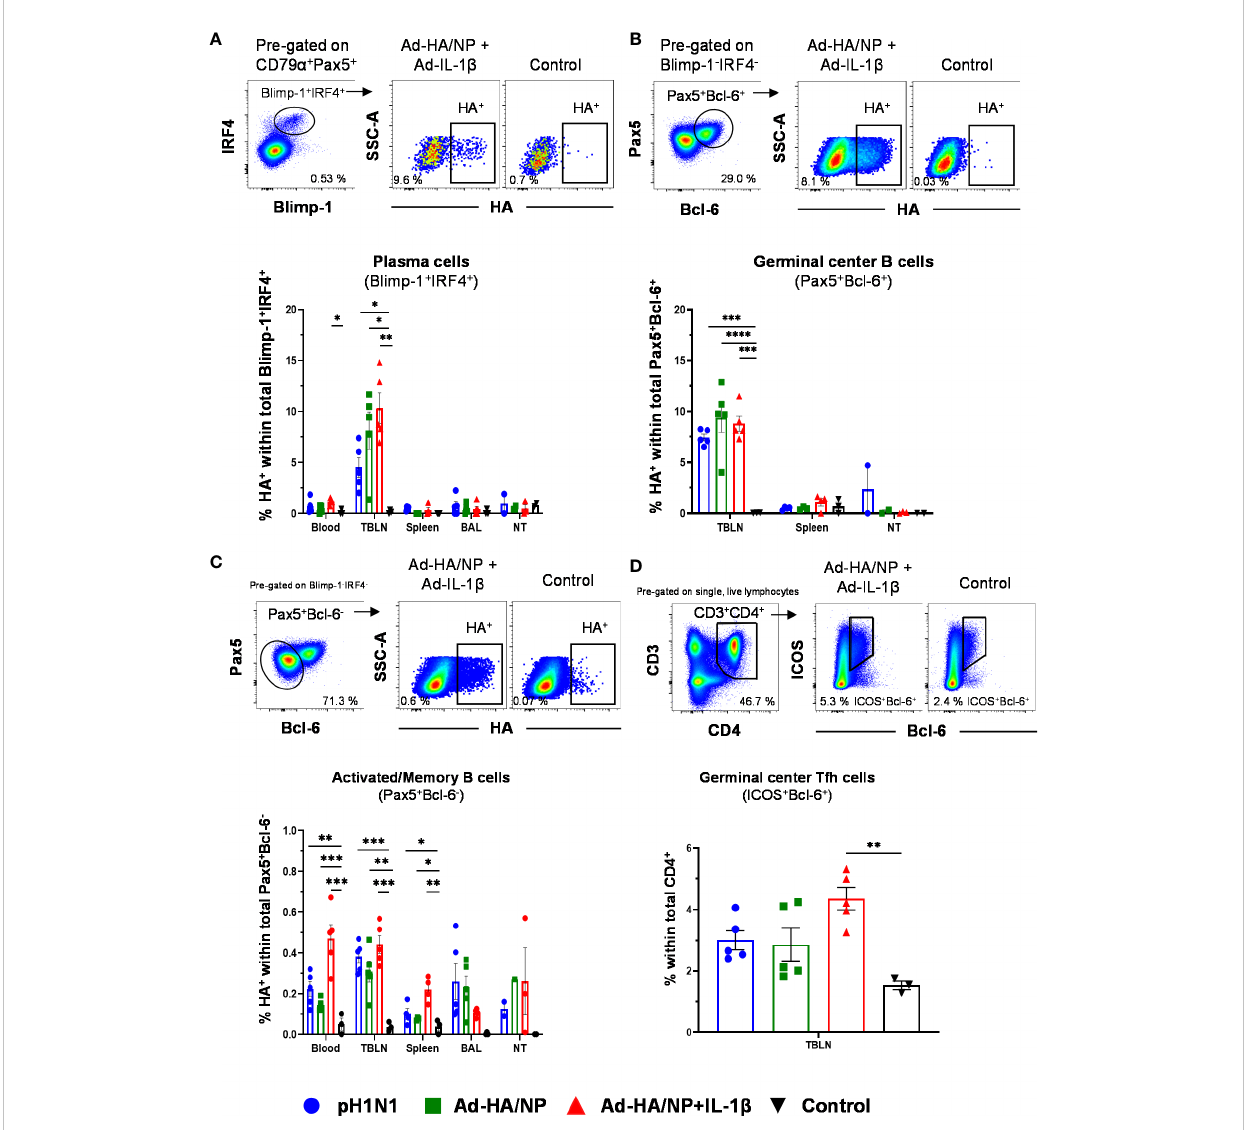
FIGURE 2 Frequencies of HA-speci fi c plasma cells, germinal center B cells, and activated/memory B cells. B cell subsets were gated as described in Supplementary Figure 1. (A) Plasma cells, (B) GC B cells, and (C) activated/memory B cells and HA-binding cells were identi fi ed within these subsets. Representative raw data is shown for an Ad-HA/NP + Ad-IL-1 b treated pig versus a control pig. Graphs below show percentages of HA-binding cells within the respective subset across tissues and treatment groups. (D) CD3 + CD4 + ICOS + Bcl-6 + Tfh cells were identi fi ed according to the gating on the top. Each symbol represents data from an individual pig of the different treatment groups. Asterisks indicate signi fi cant differences between treatment groups within one location (*, p <0.05; **, p <0.01; ***, p <0.001 and **** p